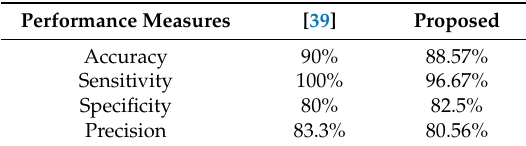
Table 2. The results of the proposed algorithm on URFD dataset and the results of the related work representing this